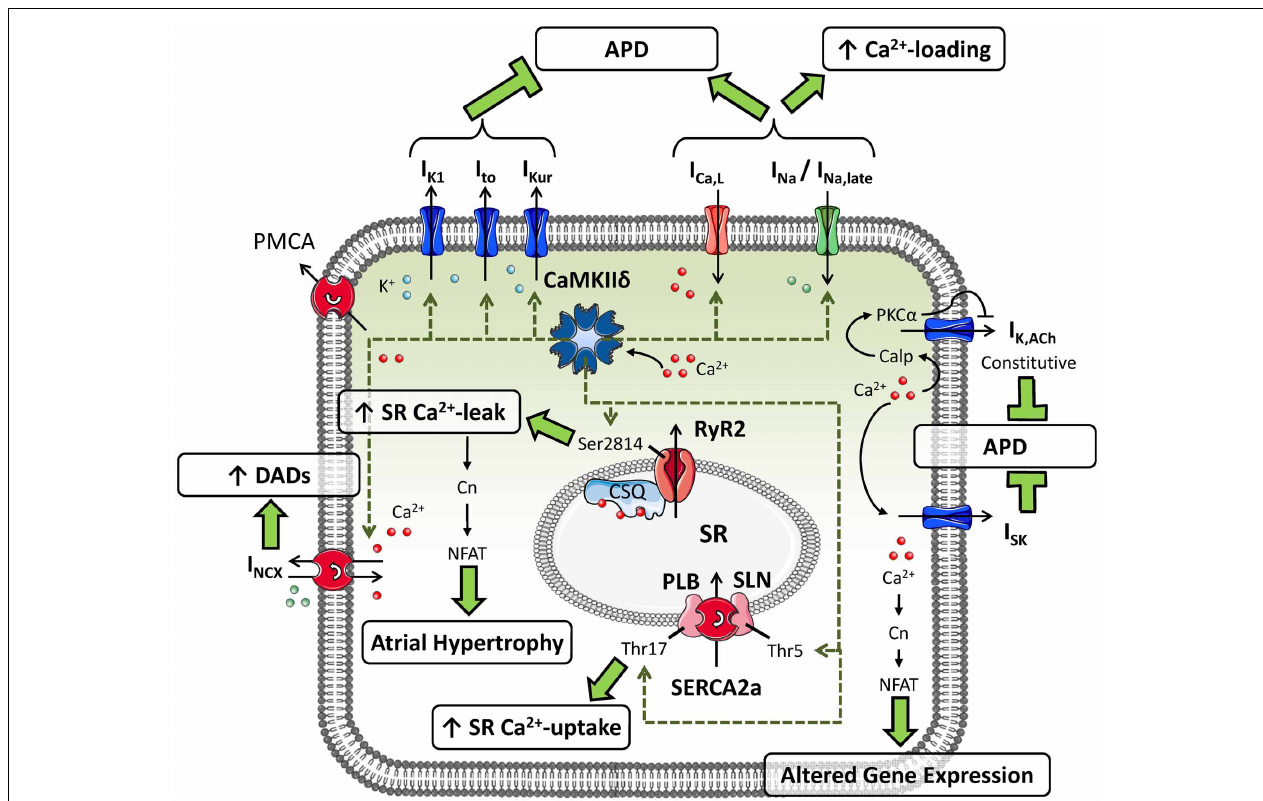
FIGURE 1 | Putative substrates for CaMKII-dependent phosphorylation in atrial cardiomyocytes and their consequences for atrial cellular electrophysiology and Ca 2 + -handling. CaMKII can phosphorylate the transient-outward K + -current (I to ), inward-rectifier K + -current (I K1 ) and ultra-rapid delayed-rectifier K + -current (I Kur ), augmenting their functions and shortening action potential duration (APD). Phosphorylation of L-type Ca 2 + -current (I Ca , L ) and Na + -current (I Na ; resulting in an increased late component: I Na , late ) by CaMKII increases intracellular Ca 2 + levels and prolongs APD. CaMKII-dependent phosphorylation of phospholamban (PLB)